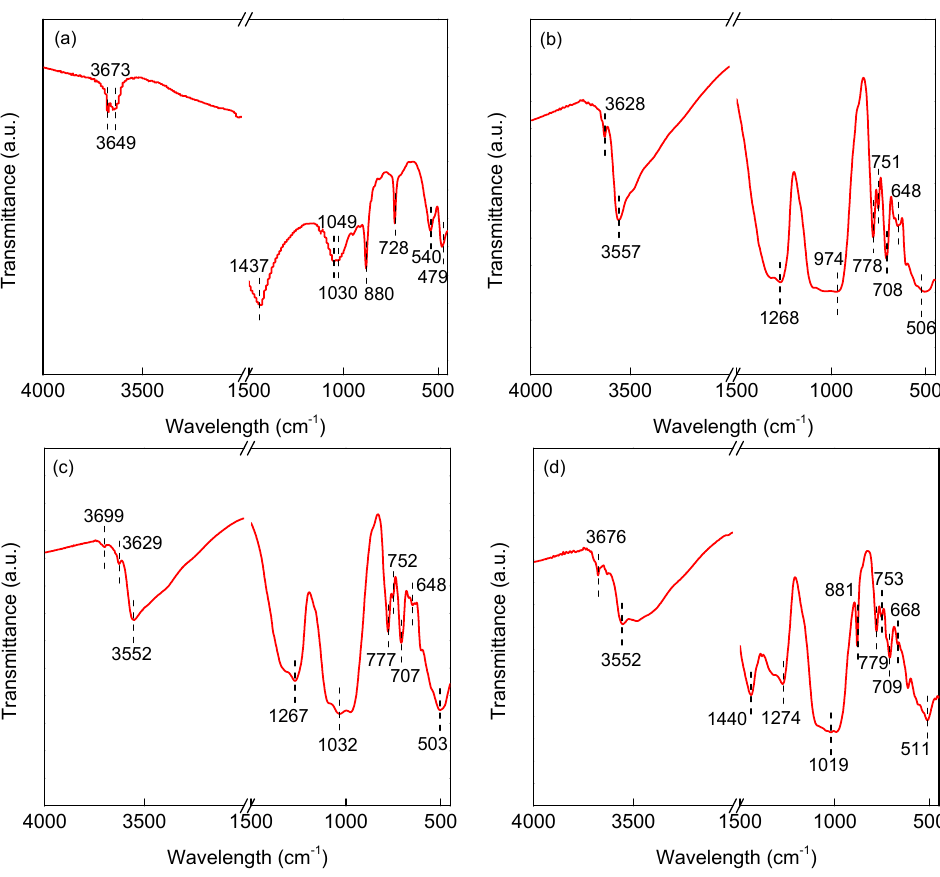
Figure 2. FTIR images of ( a ) S1, ( b ) S2, ( c ) S3 and ( d ) S4. ( a ) was reproduced from Ref. [8] with permission from Elsevier.